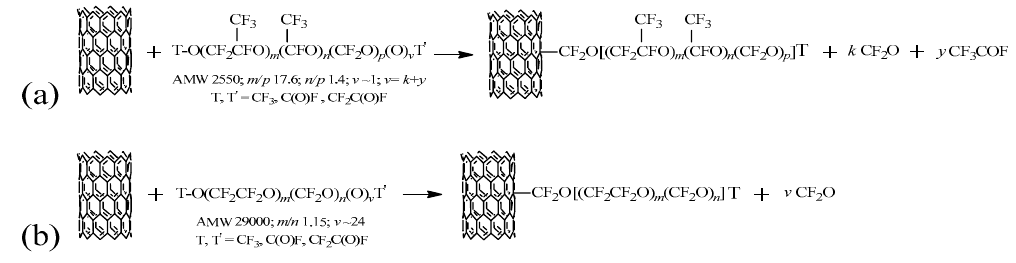
Figure 1. Functionalization reaction of MW ‐ CNTs with branched ( a ) and linear ( b ) PFPE peroxides.